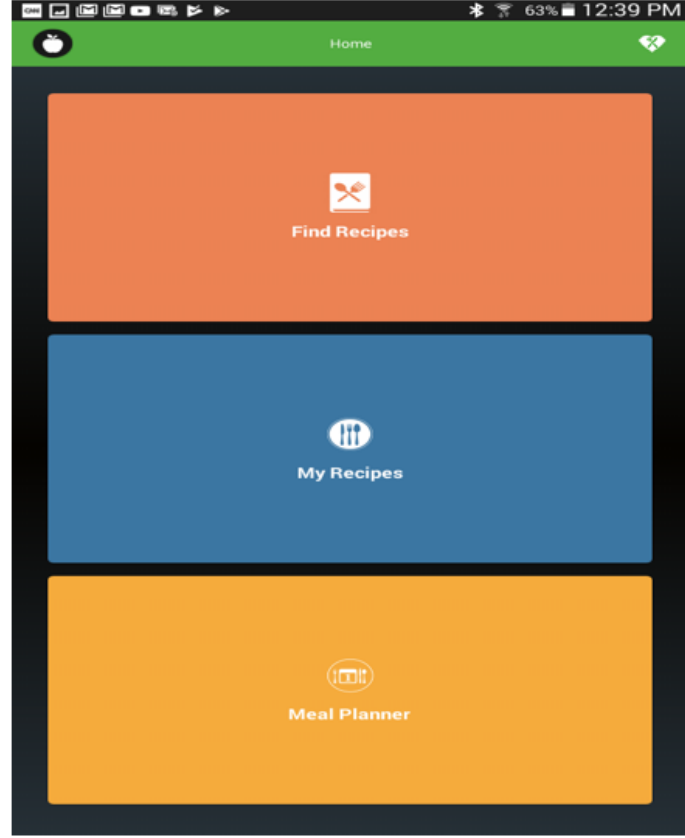
Figure 3. EasyNutrition Home page.